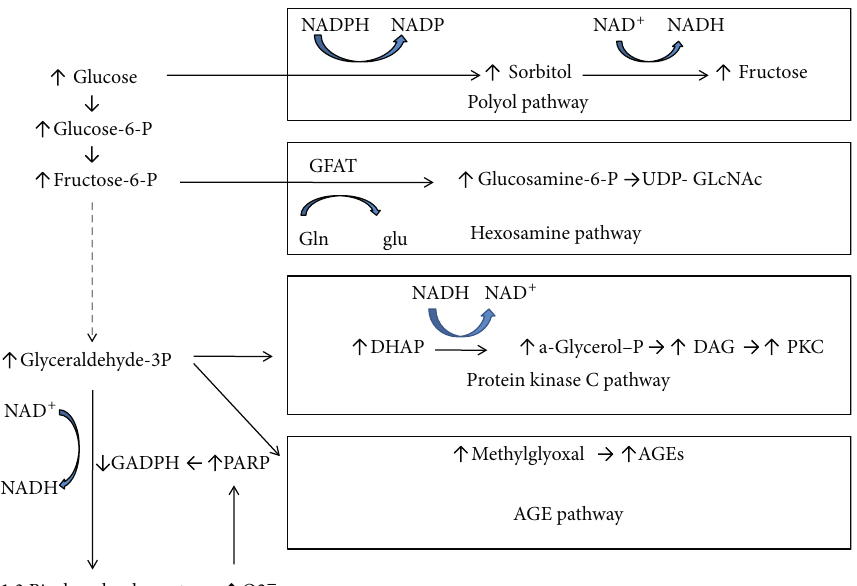
Figure 2: Mitochondrial overproduction of superoxide during hyperglycemic conditions activates four major pathways of hyperglycemic damage by inhibiting GAPDH. NADPH: nicotinamide adenine dinucleotide phosphate; NADH: nicotinamide adenine dinucleotide; GAPDH: glyceraldehyde-3 phosphate dehydrogenase; PARP: poly-ADP-ribose polymerase; GFAT: glutamine:fructose-6-phosphate amidotransferase; UDP-GlcNAc: UDP-N-acetylglucosamine; DAG: diacylglycerol; AGE: advanced glycation